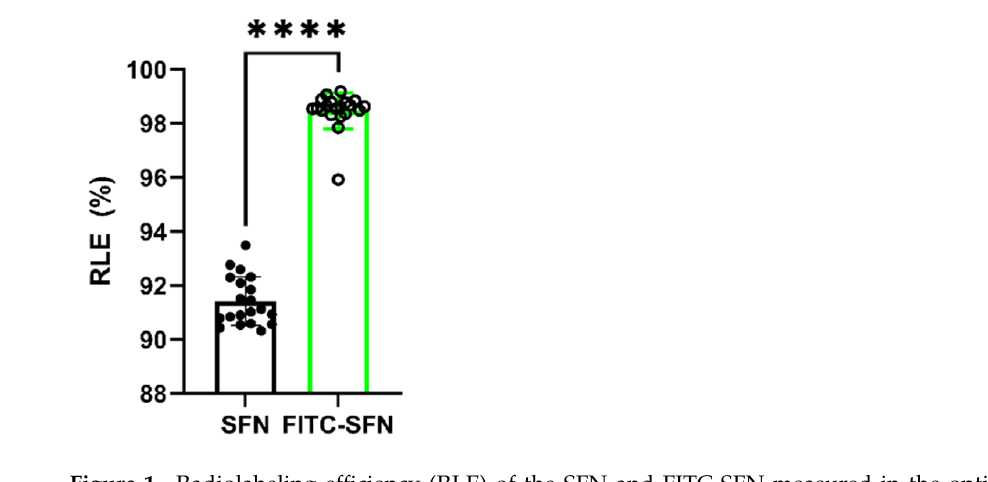
= 20) and the radiochemical purity (RCP) was found to be 99.04 ± 0.51% for [ 99m Tc]Tc-SFN Figure 1. Radiolabeling efficiency (RLE) of the SFN and FITC-SFN measured in the optimized conditions. Unpaired t -test: ****, p < 0.0001; (n = 20).